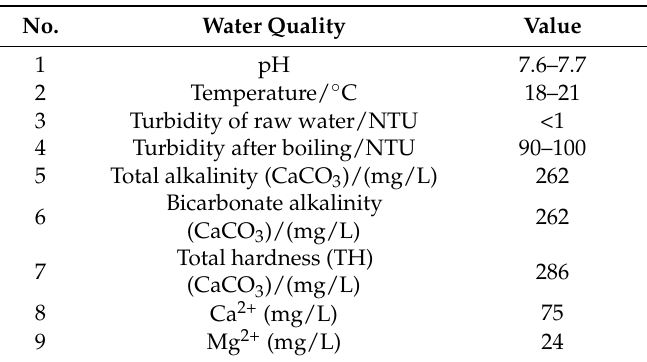
Table 1. Groundwater